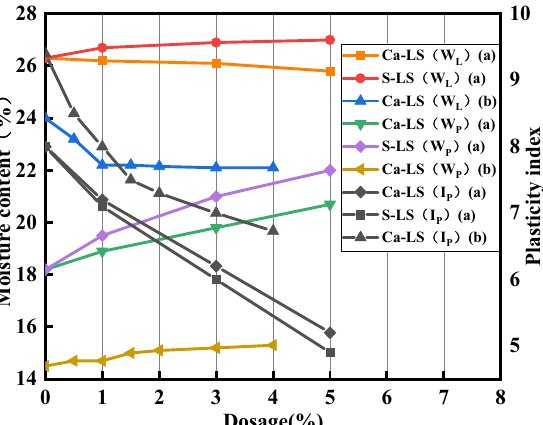
Figure 6. Variation in the moisture content limit with lignosulfonate dosage [46,49]. a: date from Hou et al. b: date from Liu. Ca ‐ LS: calcium lignosulfonate, S ‐ LS: sodium lignosulfonate, W L : liquid limit, W P : plastic limit, I P : plasticity index.